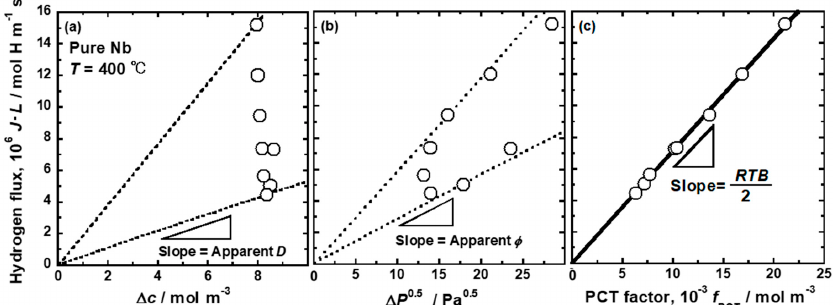
Figure 3. Changes in the hydrogen flux through pure Nb membrane at 400 °C normalized by the inverse of the membrane thickness as functions of ( a ) the differences in hydrogen concentration ( ∆ c ), ( b ) square root of hydrogen pressures between the feed and permeation sides ( Δ P 0.5 ) and ( c ) PCT factor ( f PCT ).